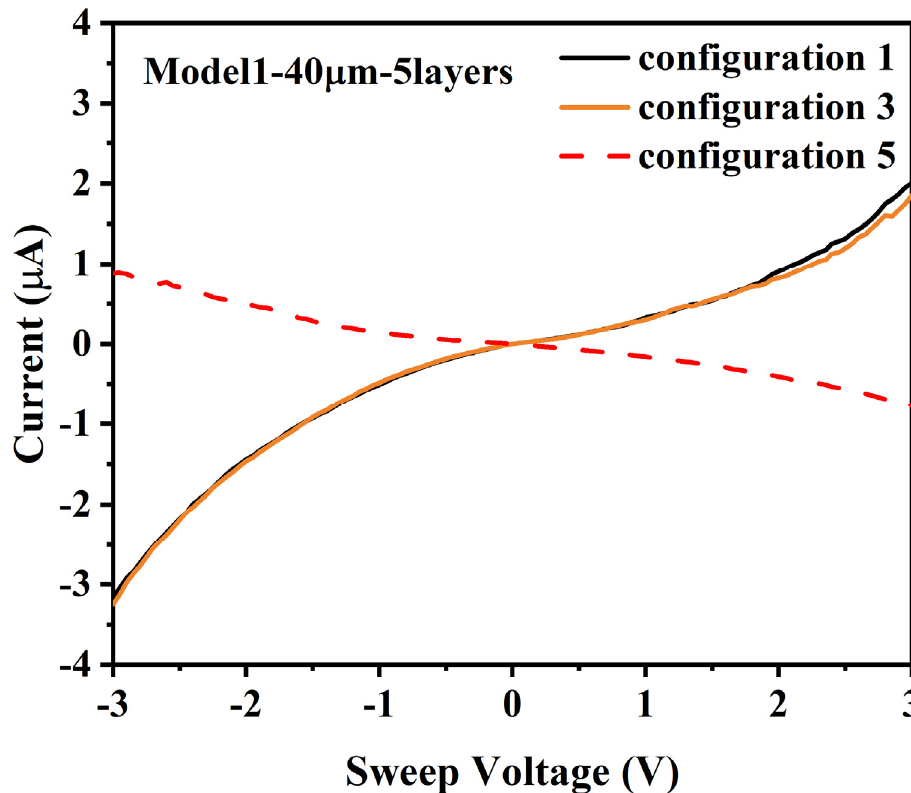
Figure 9. I/V curve for 40 µm gap, 5 layers, and voltage applied to: (configuration 1) A1, B1–B3 grounded; (configuration 3) A1, B2 grounded, B1 and B3 float; and (configuration 5) B1–B3, A1 grounded.